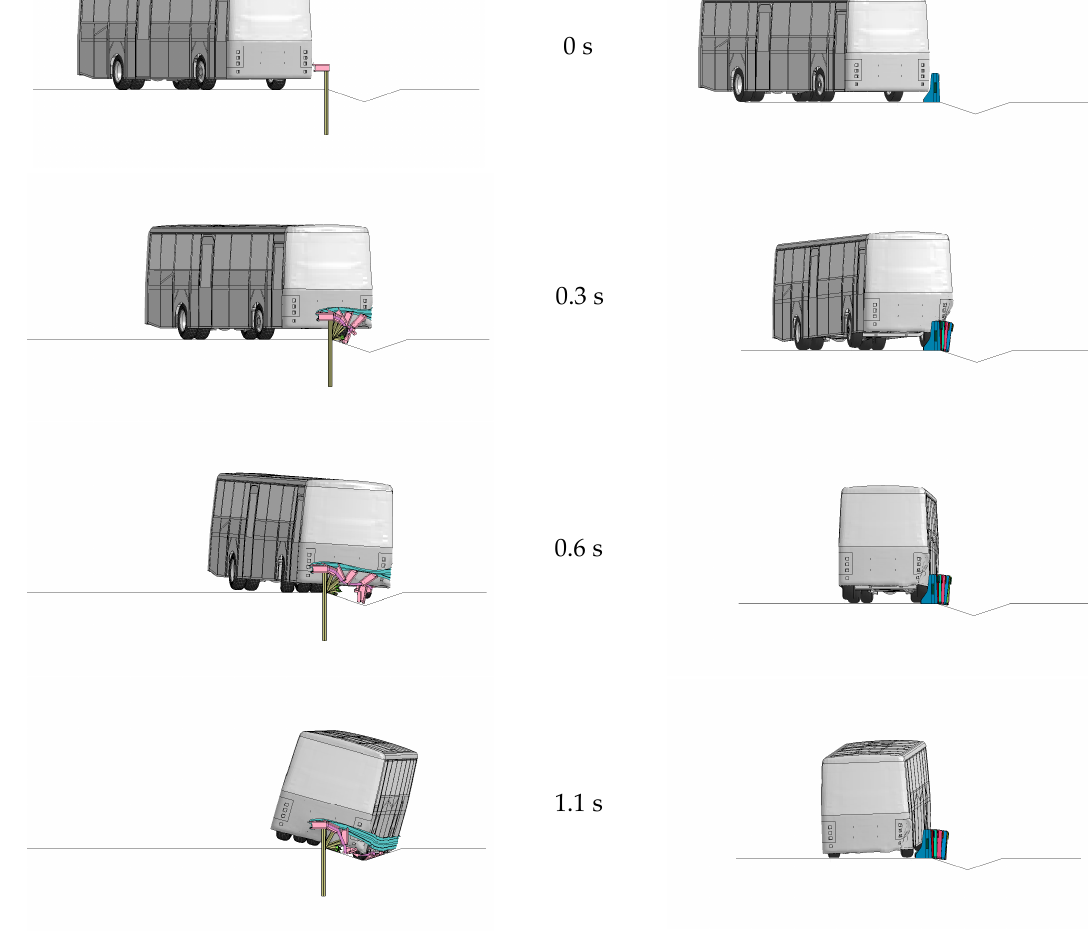
Figure 10. Sequential front-view picture comparison of steel EDSP-1.33 and concrete C470 barriers after the bus impact simulation.